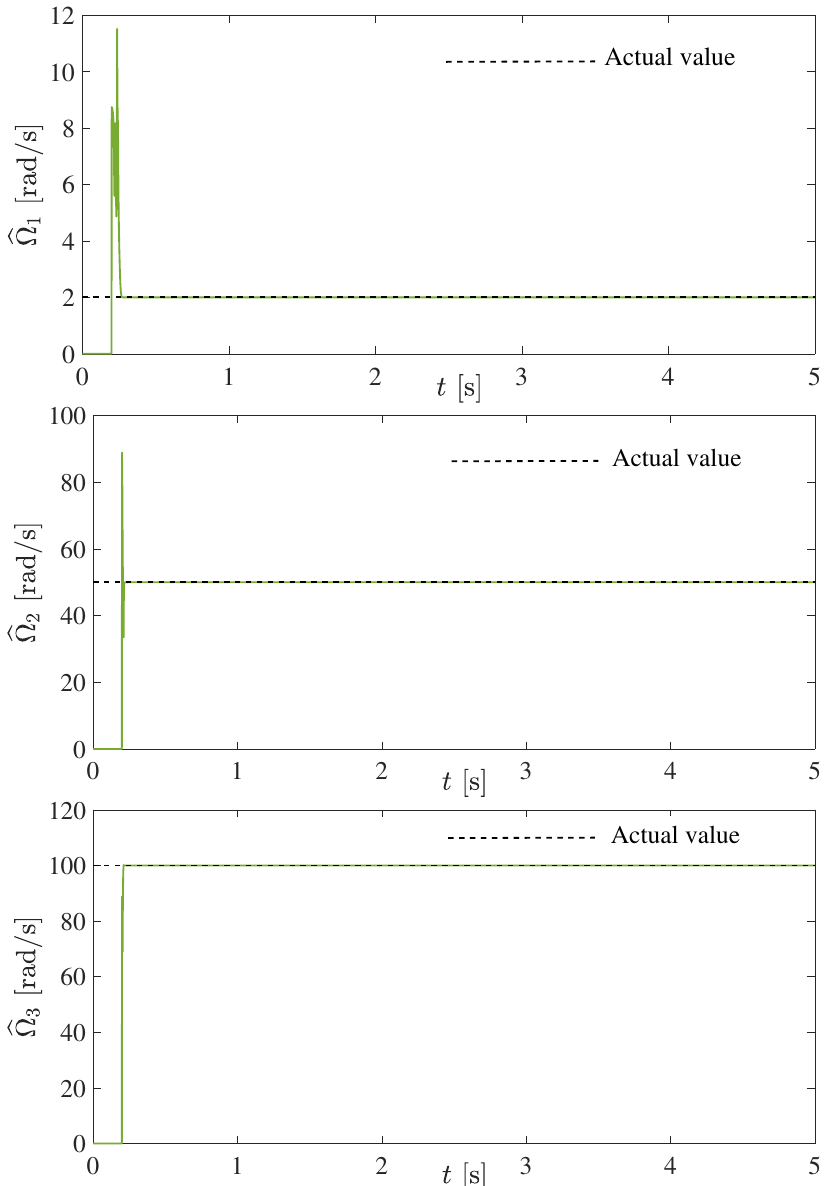
Figure 2. Online algebraic estimation of the three excitation frequencies for the 3 DOF vibrating mechanical system